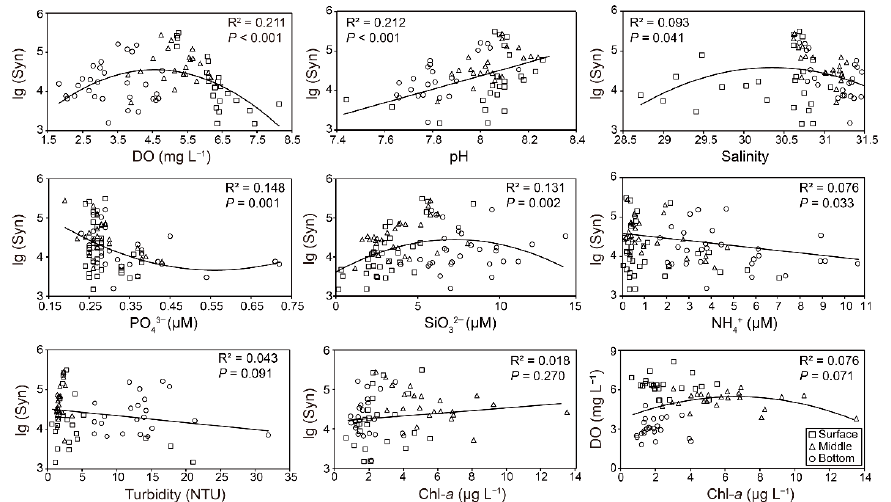
Figure 4. Regression analyses showing the relationships between log transformed cell abundance of Synechococcus (cell mL − 1 ) and environmental factors. The relationship between dissolved oxygen (DO, mg L − 1 ) and chlorophyll concentration (Chl- a ) is also shown. Only the important results are reported.